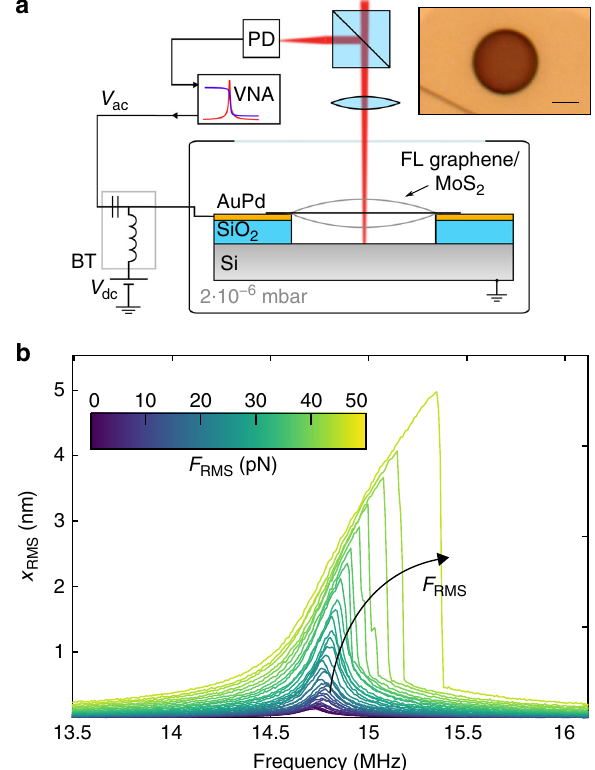
Fig. 1 Measurement setup and measured frequency response of device 1. a Schematic of the measurement setup: a laser interferometer setup is used to read out the motion of the nanodrum. The Si substrate is grounded and, using a bias-tee (BT), a combination of ac voltage and dc voltage is applied to electrostatically actuate the motion of the drum. This motion modulates the re fl ected laser intensity and the modulation is read out by a photodiode. Inset: an optical image of a FL graphene nanodrum (scale bar: 2 μ m). b Frequency response curves of the calibrated root-mean-square